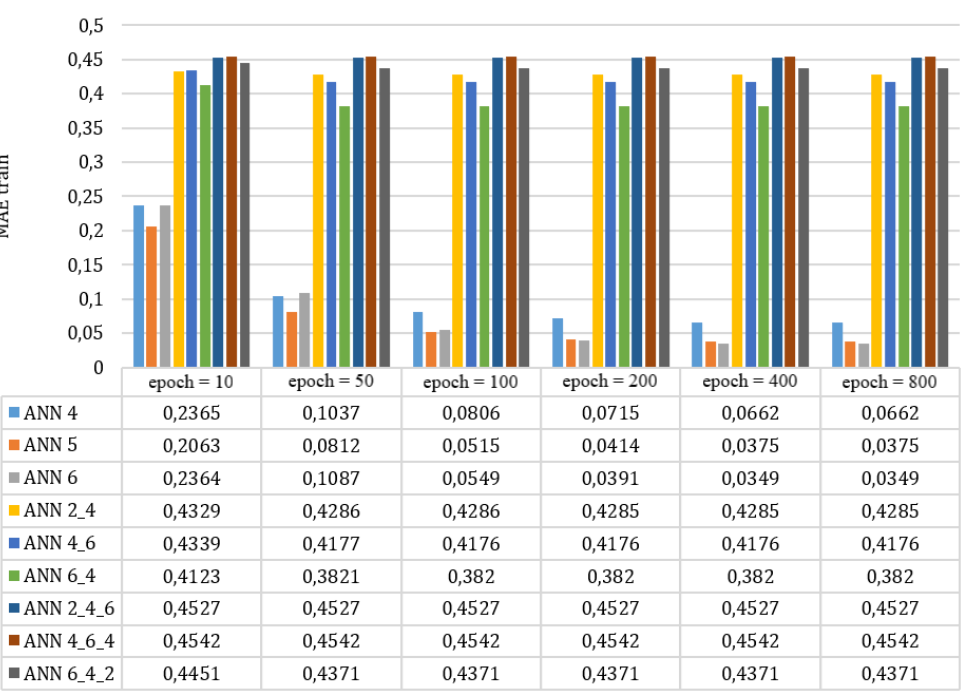
Figure 11. MSE test results of nine different ANN topologies.